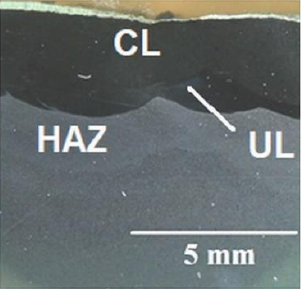
Figure 14. Macrostructure of a two-layer weld metal. (HAZ — heat-affected zone, CL — cover layer, UL — Underlying layer).